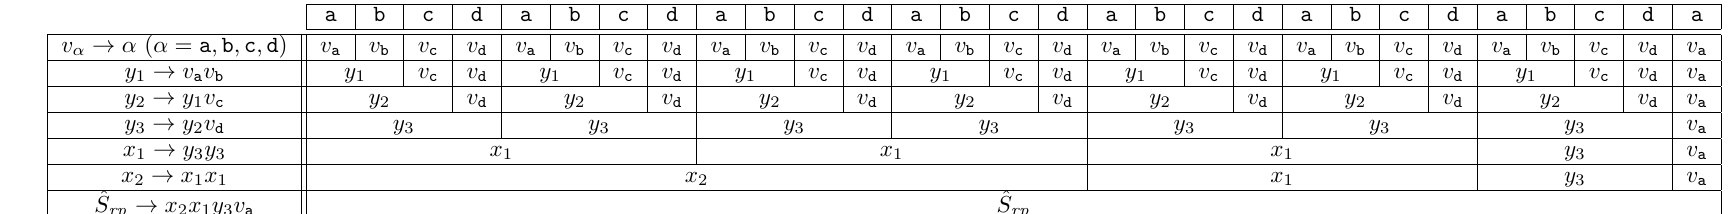
Figure A1. Grammar generation process of RePair and its generated grammar for the text ( abcd ) 7 a . The grammar size is 18.